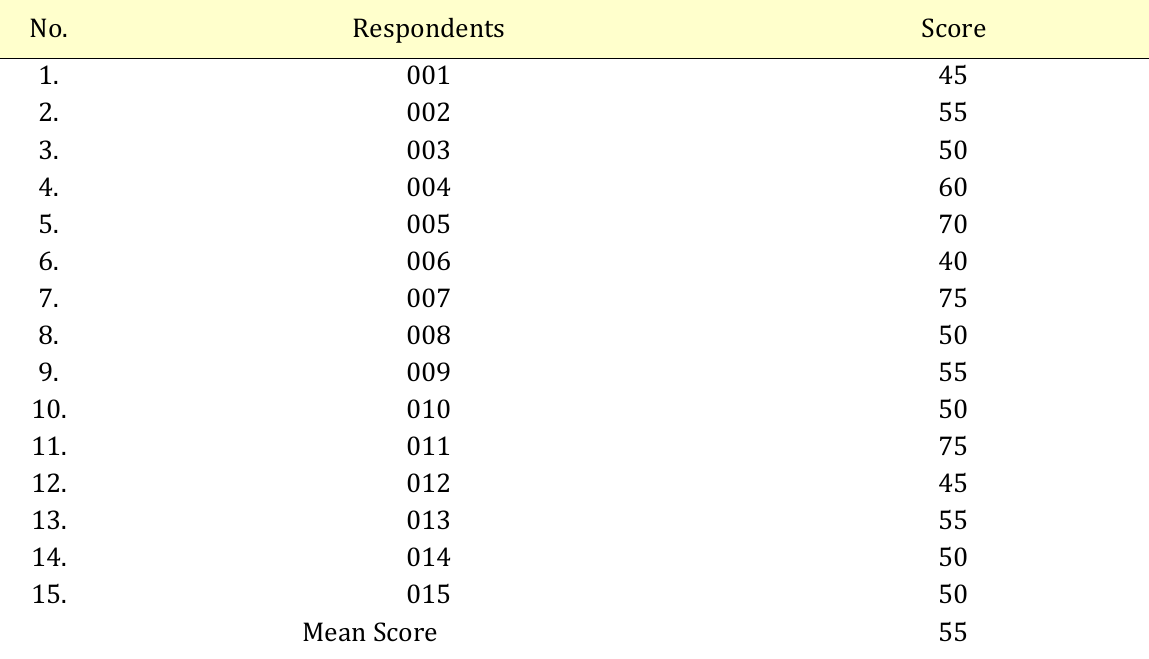
Table 5. The result of the test in cycle